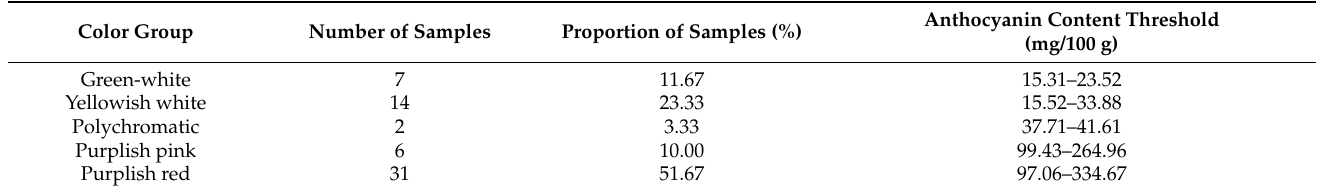
Table 7. The threshold distribution of anthocyanin content in petals of different colors of L. chinense var. rubrum